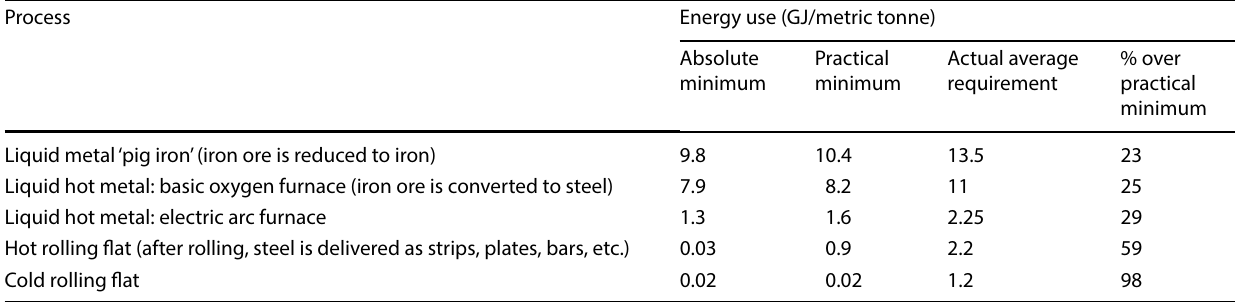
Table 12 EU-ETS benchmark values for iron and steel manufacture as of February 2020